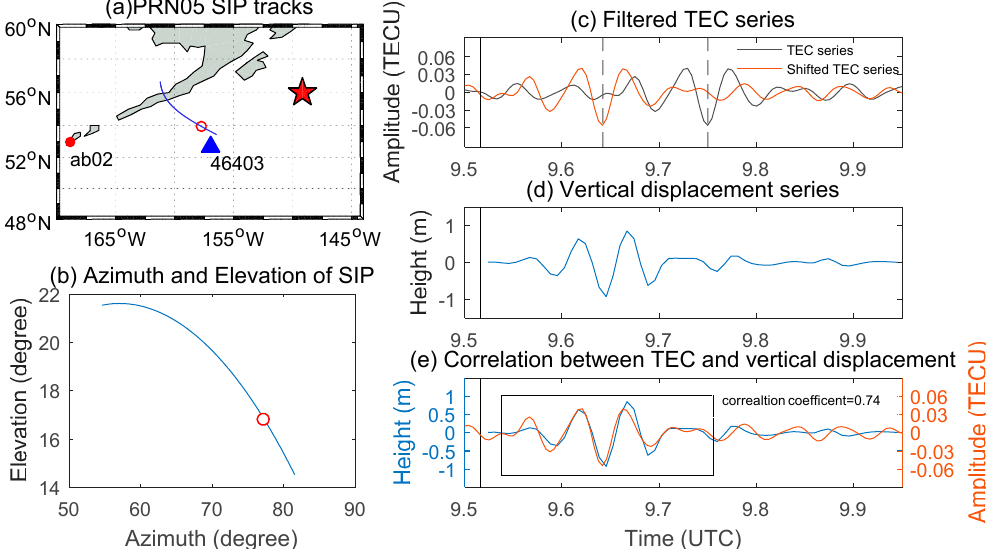
Figure 8. The correlation between filtered TEC and DART (Deep-ocean Assessment and Reporting of Tsunamis) buoy data. ( a ) shows the location of DART station 46403 and the satellite puncture. ( b ) shows the observational geometry between the station AV02 and the GPS satellite. The hollow circles in ( a , b ) show the moment when the earthquake struck. ( c ) shows the filtered TEC series of station AV02 in black and the copy of the filtered TEC series shifted 6.7 min advance in orange. ( d ) shows the vertical displacement series of station 46403. ( e ) shows the correlation between the filtered TEC series shifted 6.7 min forward and vertical displacement series.